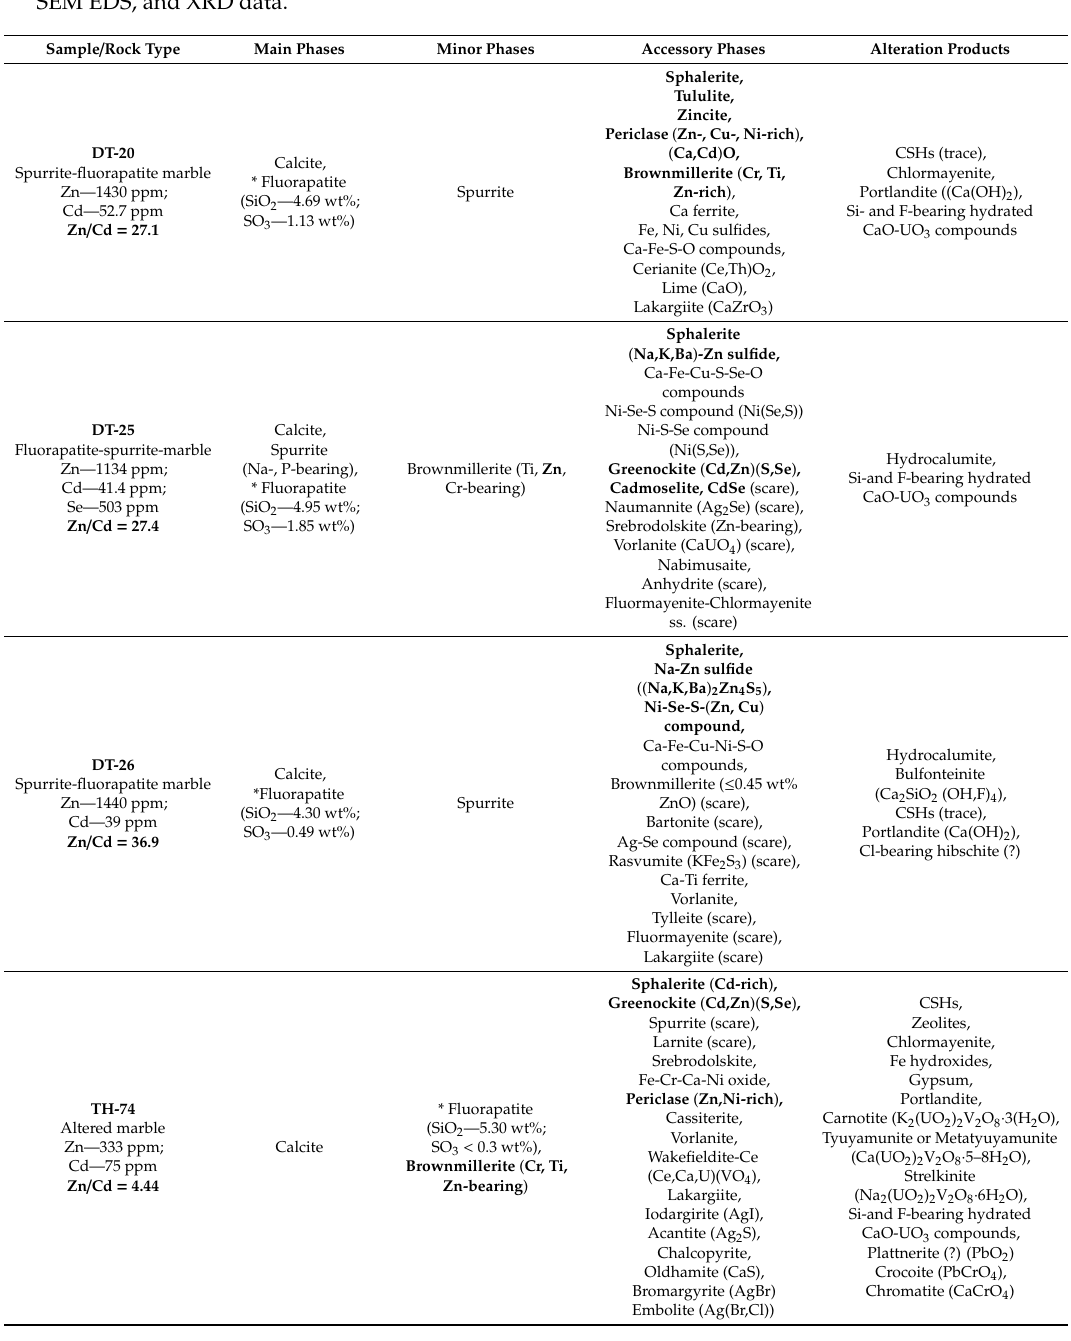
Table 4. Mineral assemblages of Zn-enriched Jordanian combustion metamorphic rocks—phosphate marbles with primarily Zn-bearing oxide and sulfide mineralization, Tulul al Hammam area. EPMA, SEM EDS, and XRD